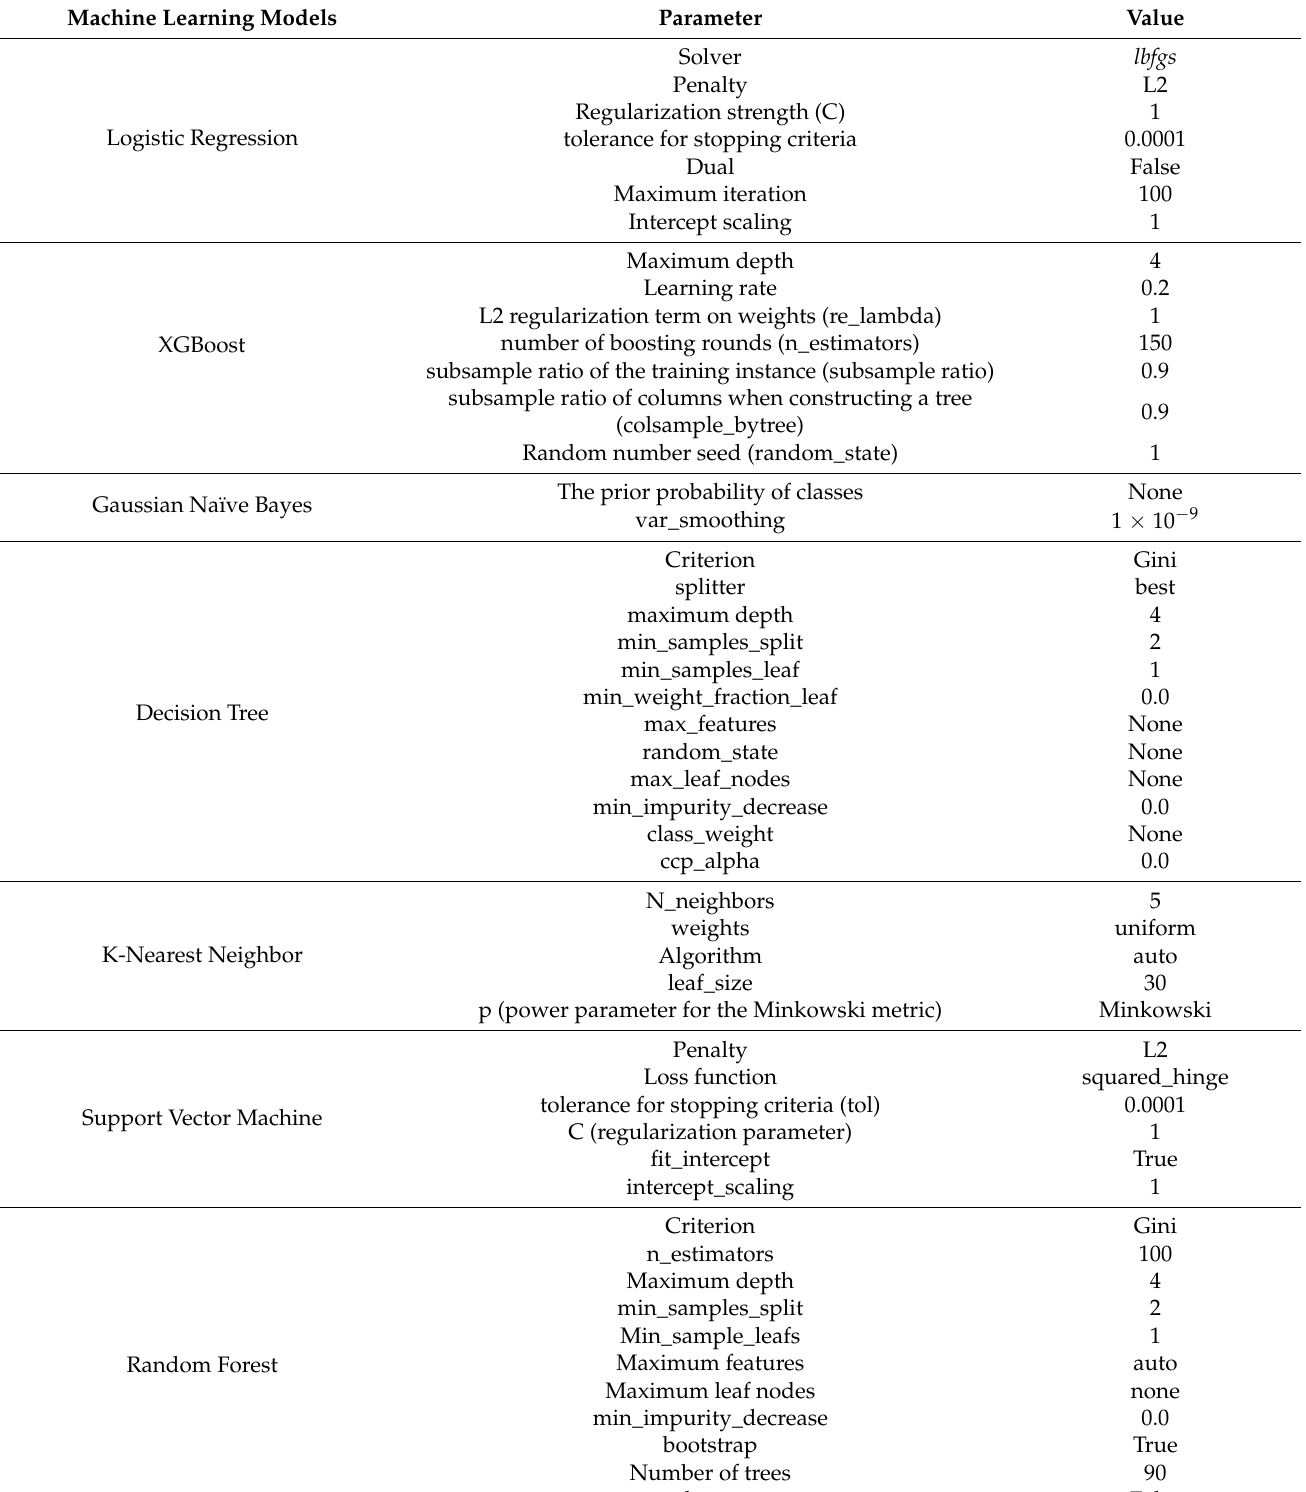
Table 4. Machine Learning models parameter